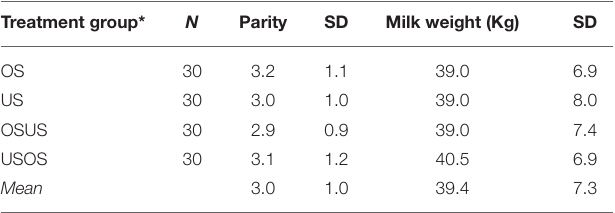
TABLE 1 | Covariates by treatment group according to parity and 305-d milk in 120 cows. Treatment